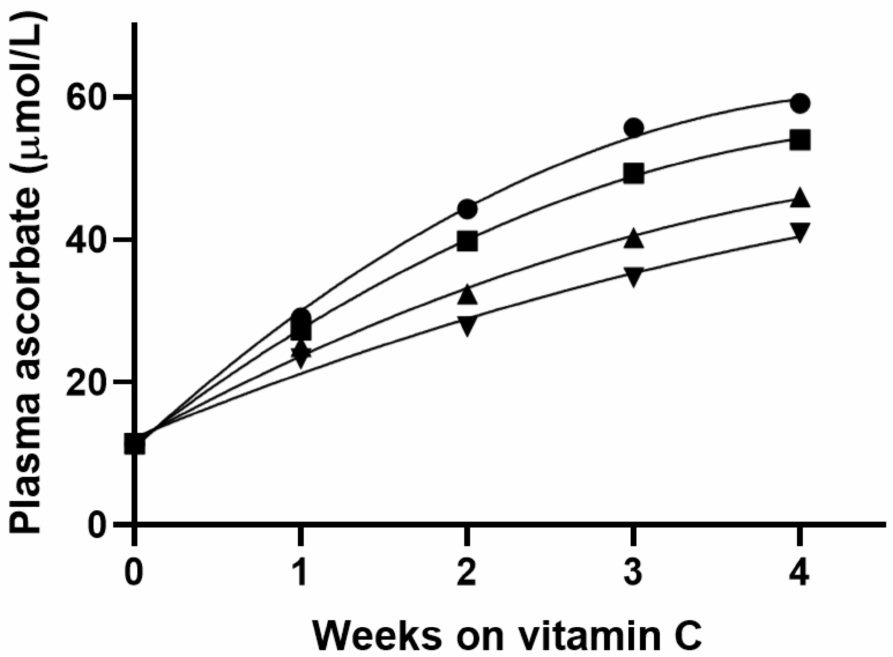
Figure 1. Predicted plasma ascorbate concentration after repletion with vitamin C (117 mg/day) by body weight. The body weights used in the model were: 59 kg (130 lbs; • ), 68 kg (150 lbs; (cid:4) ), 82 kg (180 lbs; (cid:78) ), 91 kg (200 lbs; (cid:72) ). The model assumed that all participants started at the same depleted level. Data were obtained from Table 3 in reference